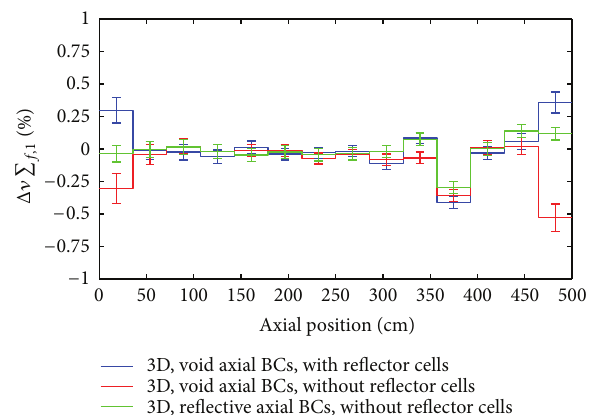
Figure 15: Relative differences between fission neutron production cross sections for the fast group.